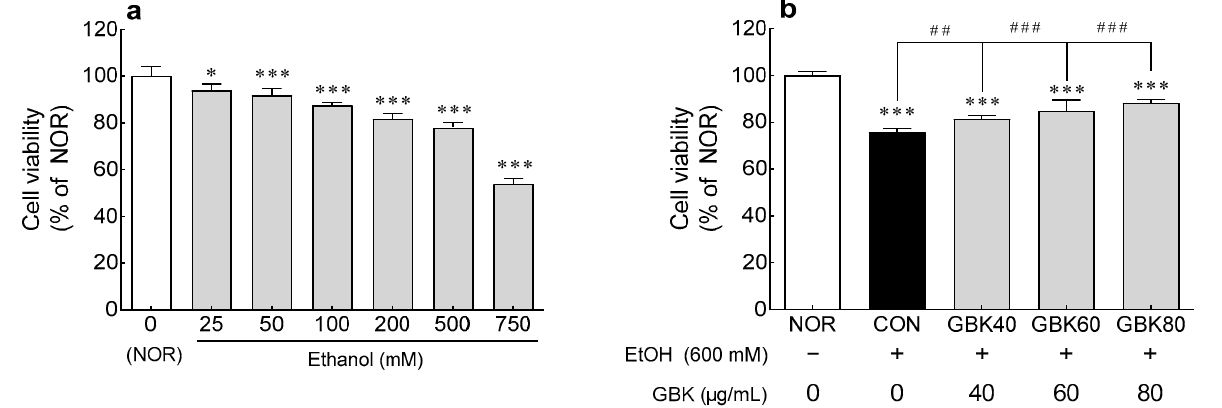
Figure 2. Effects of ( a ) ethanol alone and ( b ) GBK and ethanol mixed treatment on the viability of HepG2 cells. HepG2 cells were treated with GBK in the presence or absence of ethanol for 24 h. Values are mean ± SD. * p < 0.05 and *** p < 0.001 vs. normal group; ## p < 0.01 and ### p < 0.001 vs. control group (ANOVA followed by Tukey’s test). EtOH, ethanol.